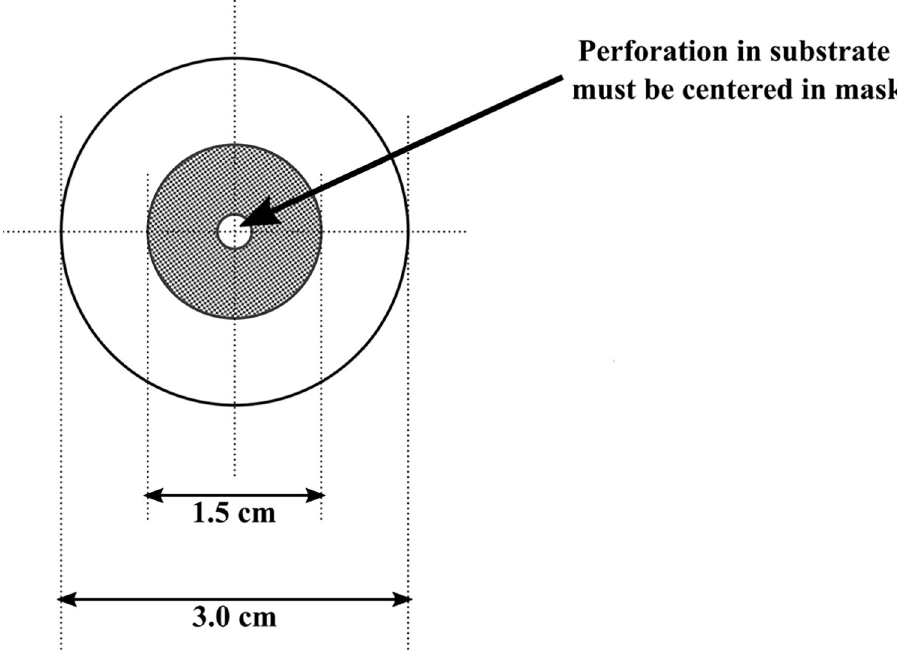
Fig 9. Test system